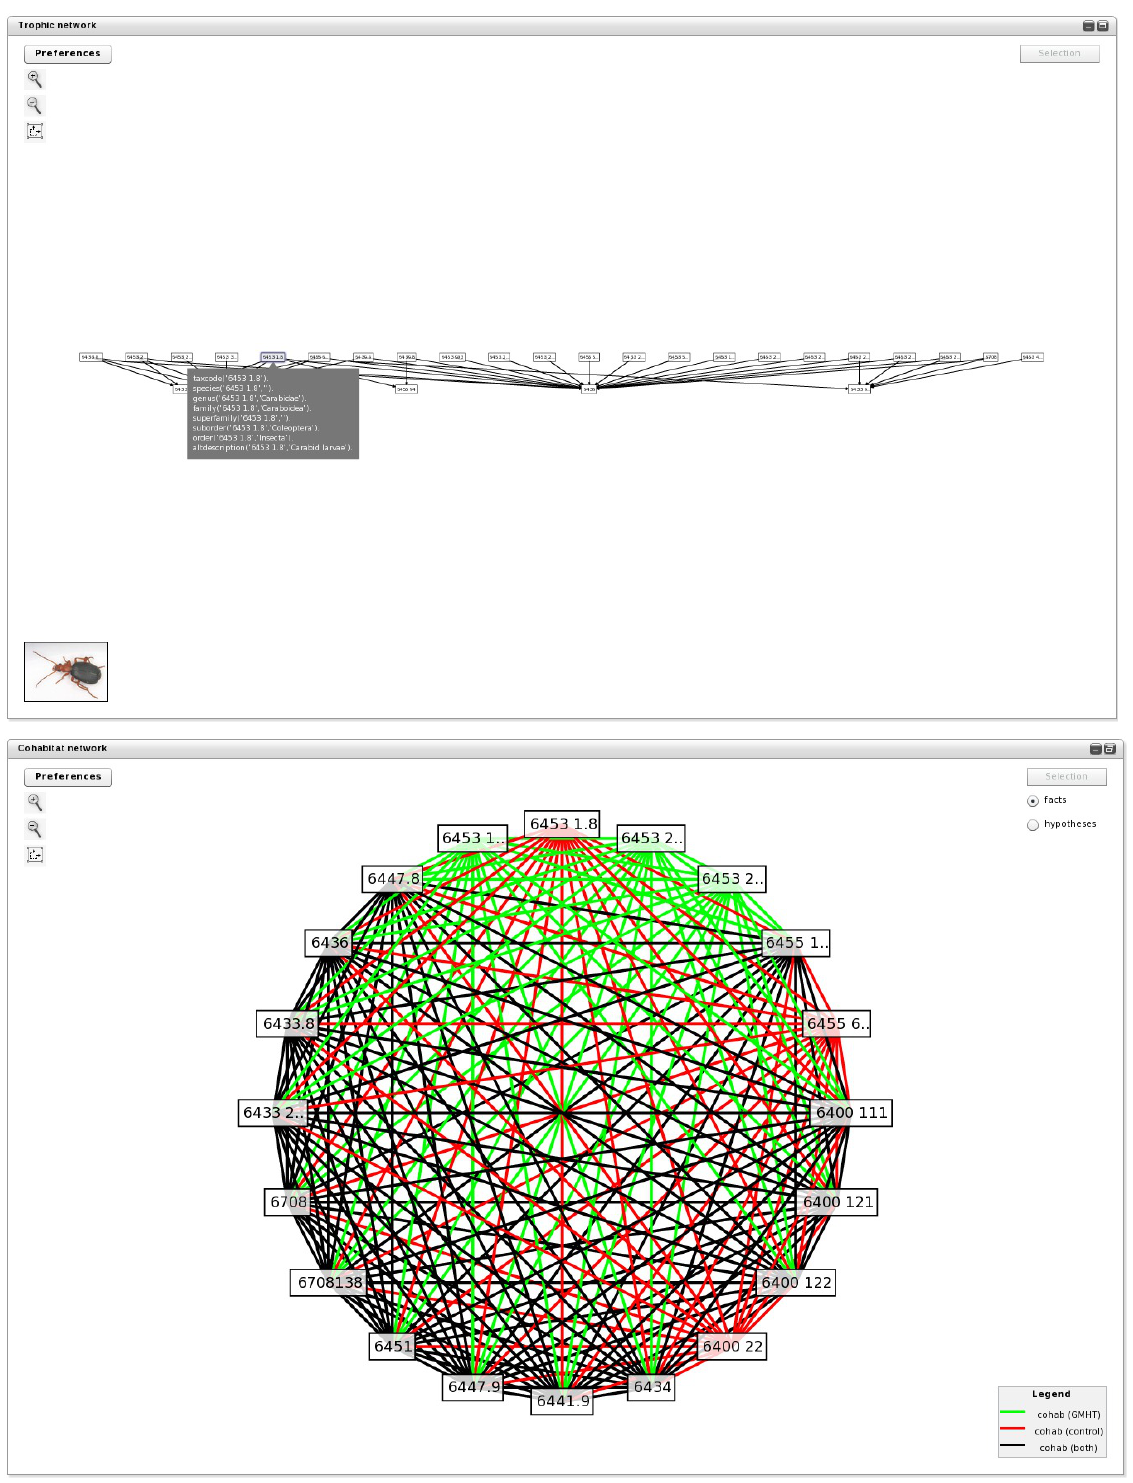
Figure 5 Co-habitat and food web visualization